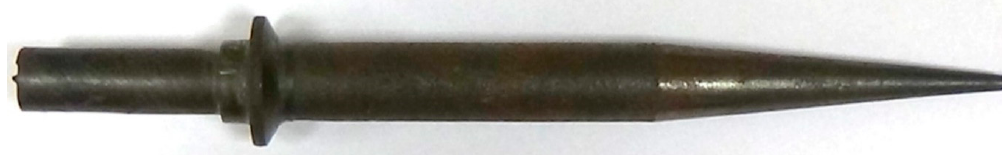
Figure 4. The cross-wedge rolling (CWR) process of the harrow tooth preform conducted in laboratory conditions in the Lublin University of Technology.